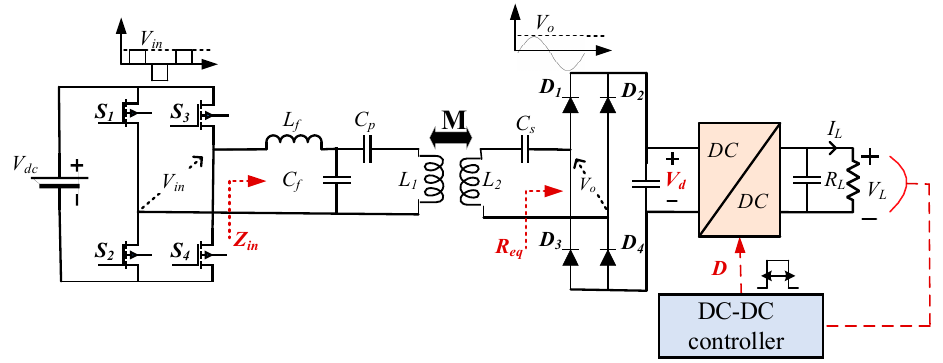
Figure 25. Receiver-side dc-dc converter control for a WPT system.